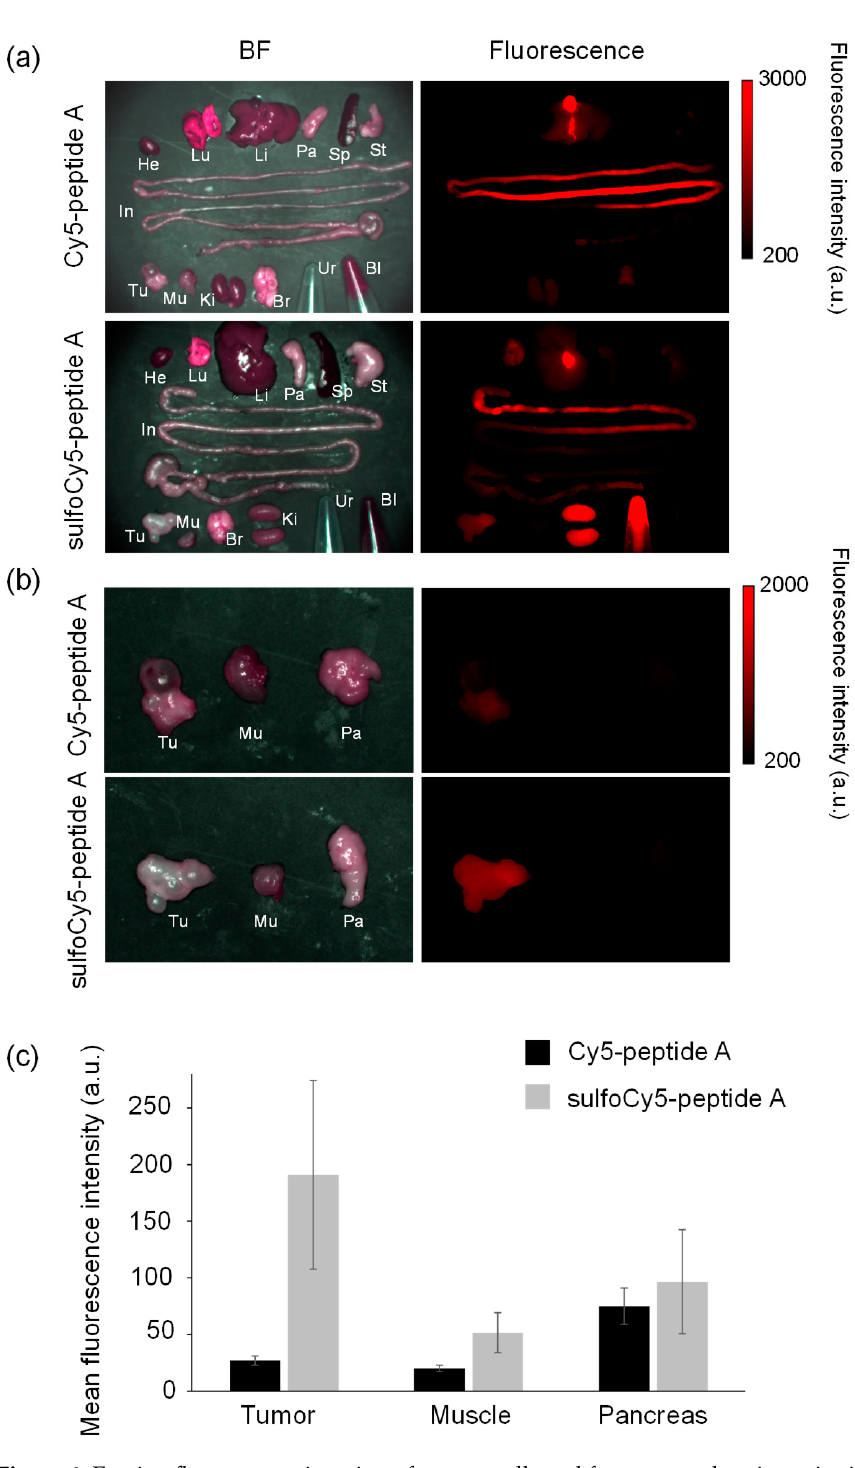
Figure 6. Ex vivo fluorescence imaging of organs collected from tumor-bearing mice injected with dye-peptide A. He, heart; Lu, lung; Li, liver; Pa, pancreas; Sp, spleen; St, stomach; In, intestine; Br, brain; Ki, kidney; Mu, muscle; Tu, tumor; Ur, urine; Bl, blood. Comparison of ( a ) all organs, urine, and blood, and ( b ) tumors, muscle, and pancreases. ( c ) The comparison of the mean fluorescence intensity of tumors, muscle, and pancreases. The data represent the mean ± SEM ( n = 3).